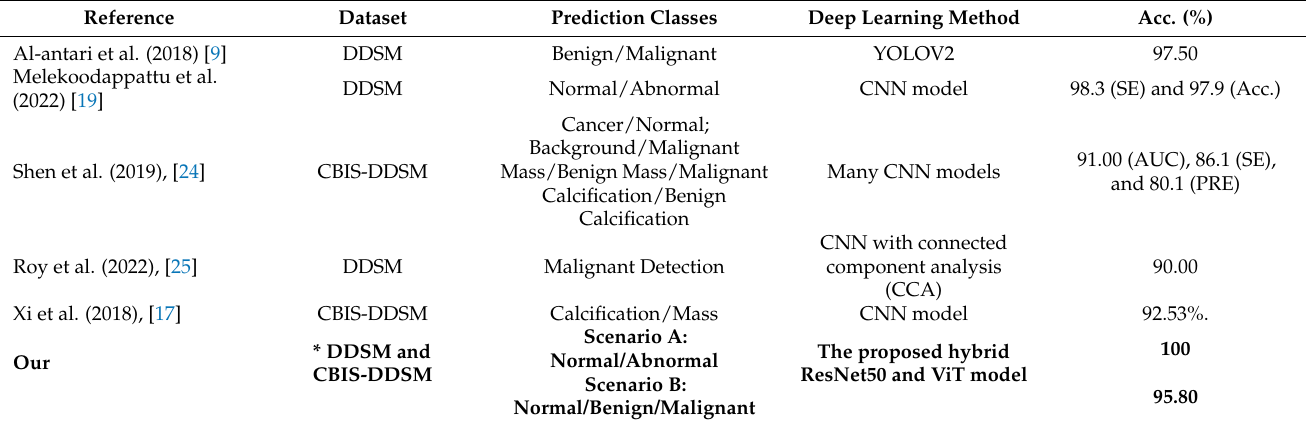
Table 12. Comparison evaluation study with the latest AI-based breast cancer classification